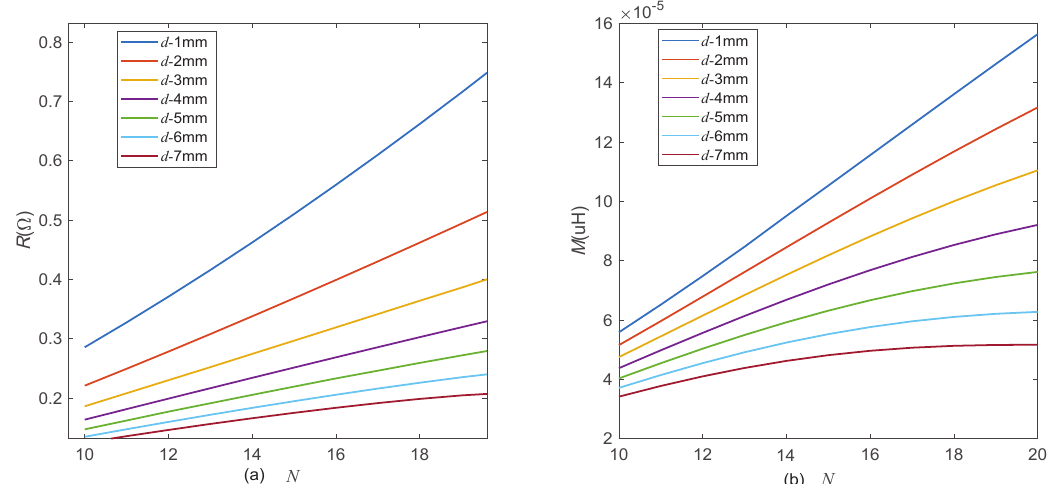
Figure 4. ( a ) Curve of resistance with turn number N and the distance d between adjacent turn. ( b ) Curve of M with turn number N and the distance d between adjacent turn.